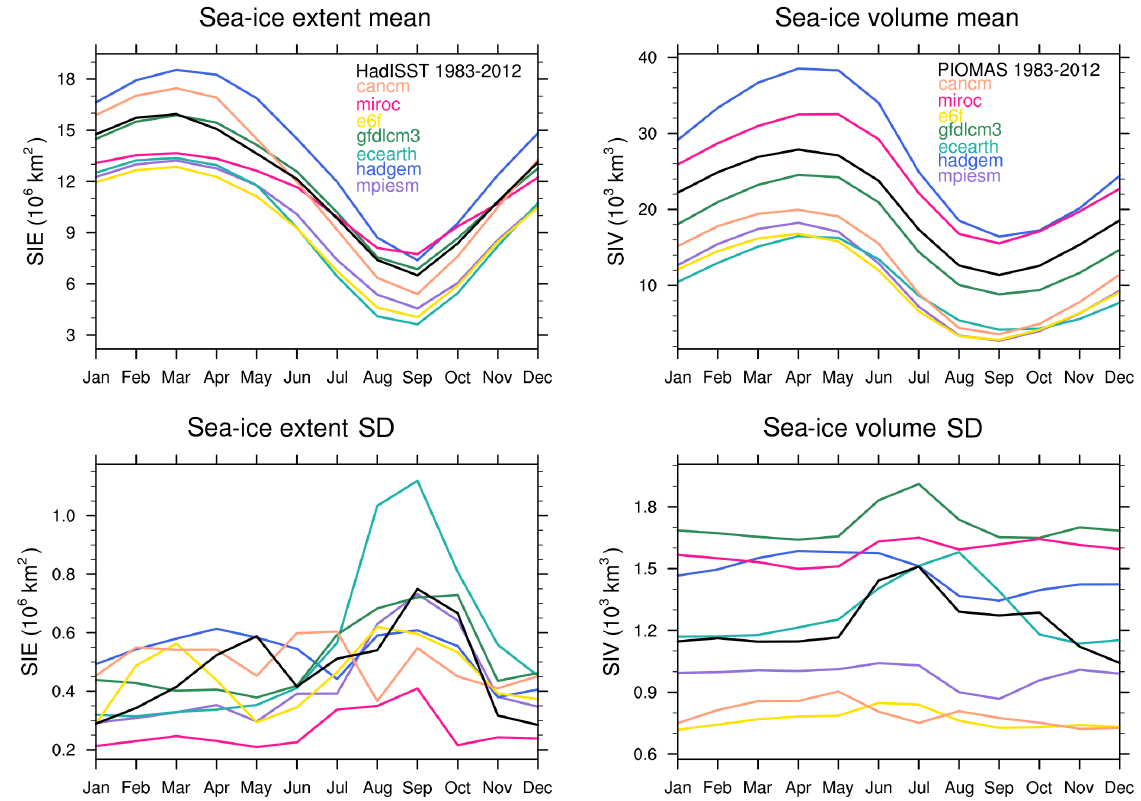
Figure 4. Seasonal cycle of monthly mean sea ice extent (a) , volume (b) and standard deviation of sea ice extent (c) and volume (d) in present-day model control simulations. The HadISST observations of sea ice extent and PIOMAS reconstruction of ice volume are included as a reference. These data were linearly detrended prior to calculating the